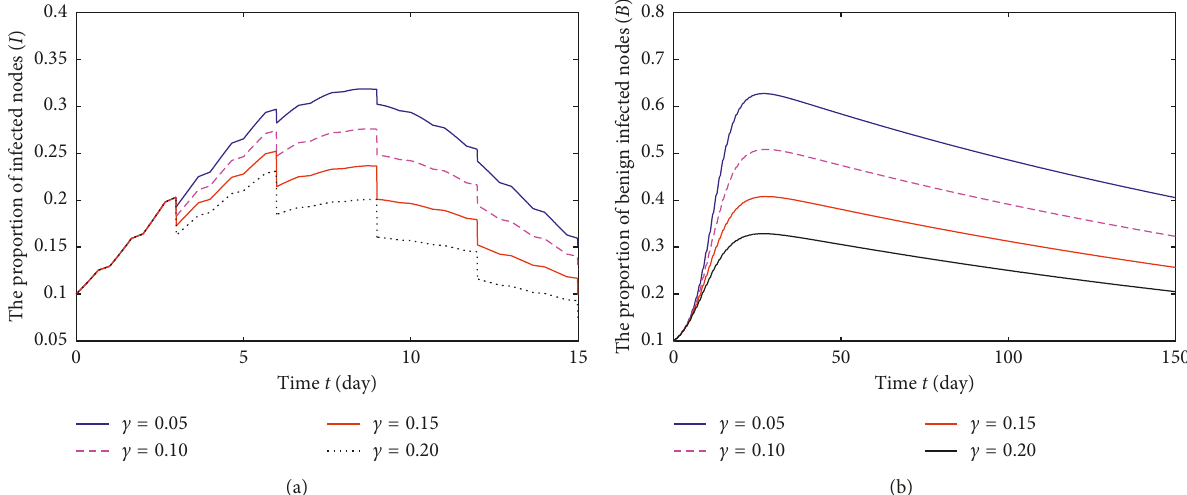
Figure 5: Evolution of I ( t ) and B ( t ) of system (5) for the different values of quarantine rate c .